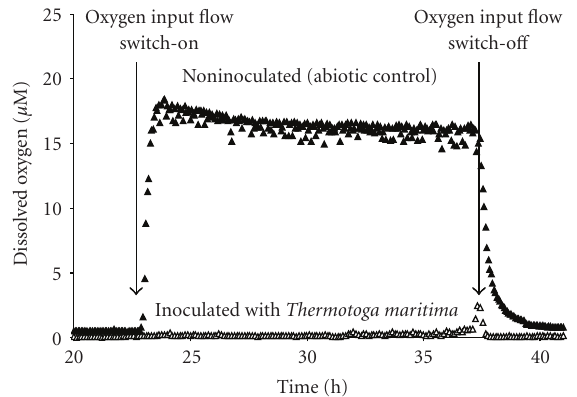
Figure 4: Dissolved oxygen measurements ( bioreactor used as a control and ( Δ ) in a bioreactor inoculated with T. maritima , during the long oxygen pulse of the oxidative period (between 23 and 37 hours). The arrows indicate the oxygen input flow switch-on and switch-o ff ,